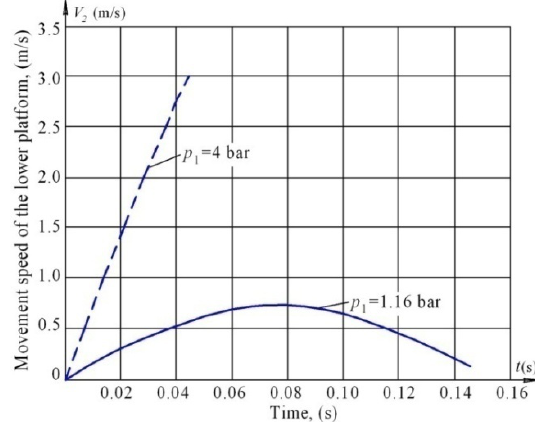
Figure 4. Change in the speed of movement of the lower platform at different pressure p 1 in the diaphragm drive under the conditions: D =0.2(m); d =0.04(m); S 2 =0.35 D (m); m 1 = m 2 =40(kg)